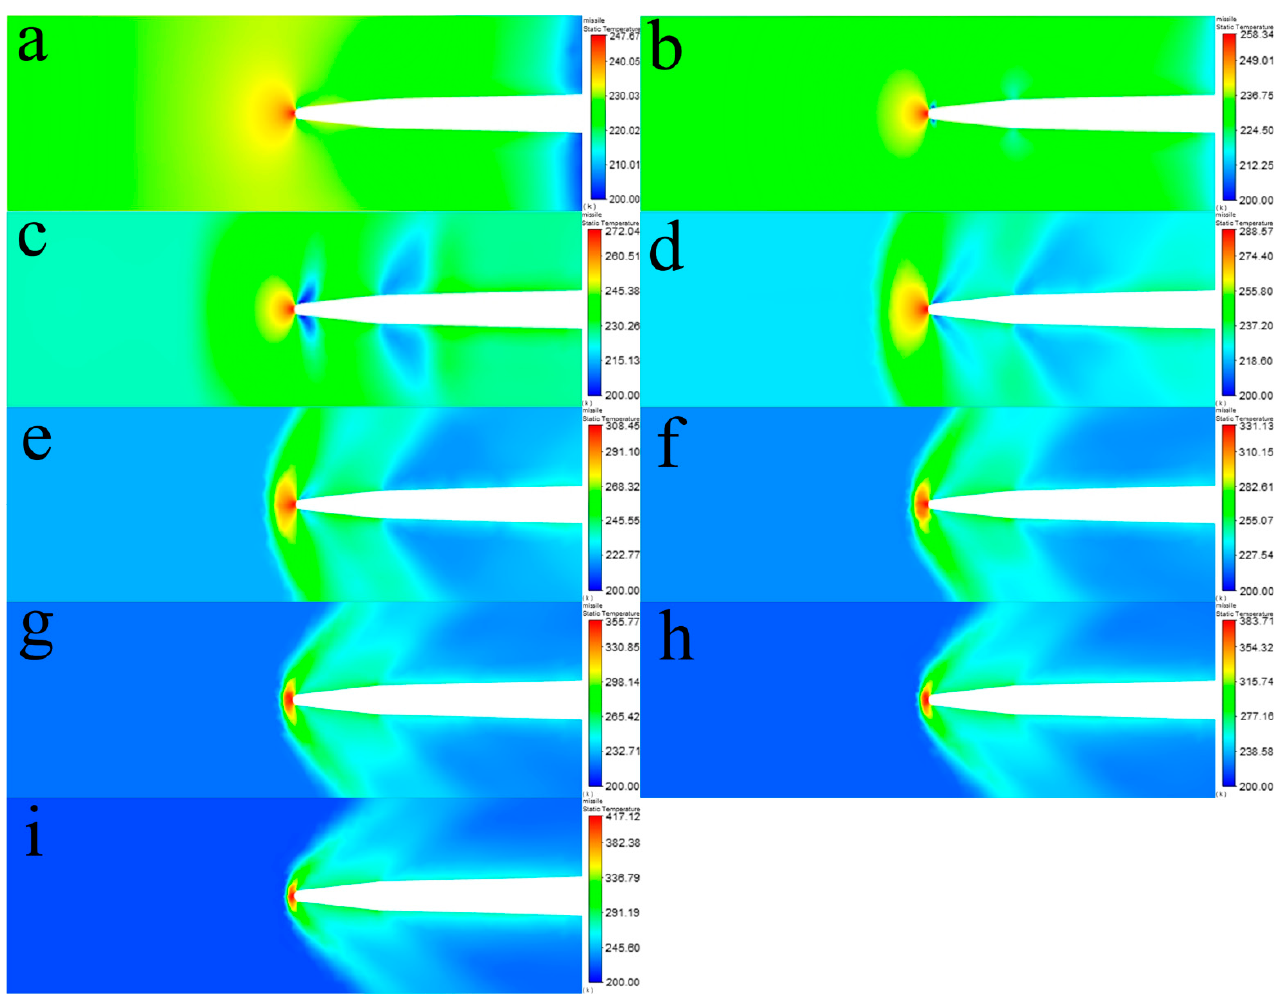
Figure 4. The contours of groups ( a – i ) with attack angle 0 ◦ . According to the contours of all groups (a–D) in Figures 4–6, the finite element calcula- tion results of three chosen calculated objects (Wall 0, Wall 1, Wall 2) from the hypersonic flying object’s warhead are plotted to scatter graphs in Figures 8–10. Figure 8a–c is con- nected to the relationship of Wall 0 between position and temperature; Figure 9a–c is connected to that of Wall 1; Figure 10a–c is connected to that of Wall 2. As a result, tempera- ture values are positively associated with the flight Mach